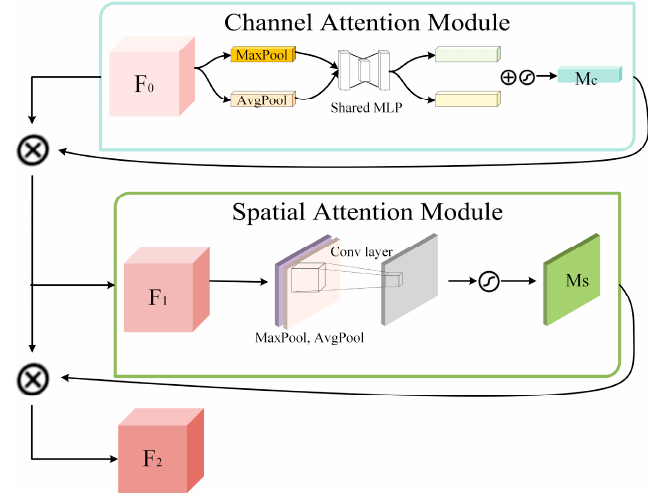
Figure 7. The structure of